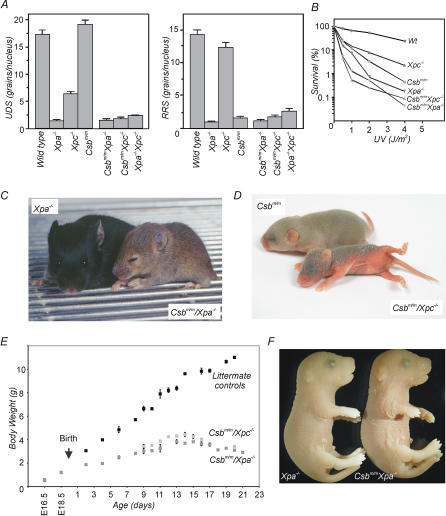
Growth Retardation, Cachexia, and Premature Death in Csbm/m/Xpa−/− and Csbm/m/Xpc−/− Mice(A) UV repair characteristics of wt, single-mutant, and double-mutant primary MEFs. UV-induced UDS (left panel) and recovery of RNA Synthesis (RRS, right panel) are indicative for GG-NER and TC-NER capacity, respectively. For a detailed explanation of the procedure, see Methods. Error bars indicate standard error of the mean (SEM).(B) Survival of primary MEFs exposed to increasing doses of UV-C light (254 nm), as determined using the with [3H]-thymidine incorporation assay. Error bars (in most cases smaller than symbols used) indicate SEM.(C) Photograph of a 14-d-old Csbm/m/Xpa−/− mouse with an Xpa−/− littermate (hybrid 129Ola/C57BL/6J background).(D) Photograph of an 8-d-old Csbm/m/Xpc−/− mouse with a Csbm/m littermate (hybrid 129Ola/C57BL/6J background).(E) Body weight curve of Csbm/m/Xpa−/− and Csbm/m/Xpc−/− mice (n = 7) compared to those defective in a single NER gene (n = 7) all in a hybrid 129Ola/C57BL/6J background. The arrow indicates birth. Error bars (in most cases smaller than symbols used) indicate SEM.(F) Photographs of day 18.5 Csbm/m/Xpa−/− and Xpa−/− embryos (C57BL/6J).